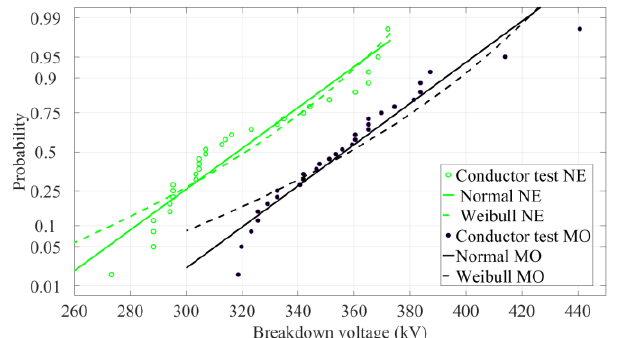
Figure 6. Weibull and normal distribution for natural ester liquid and mineral oil fitted to the measured conductor data at a gap distance of 20 mm and positive polarity.